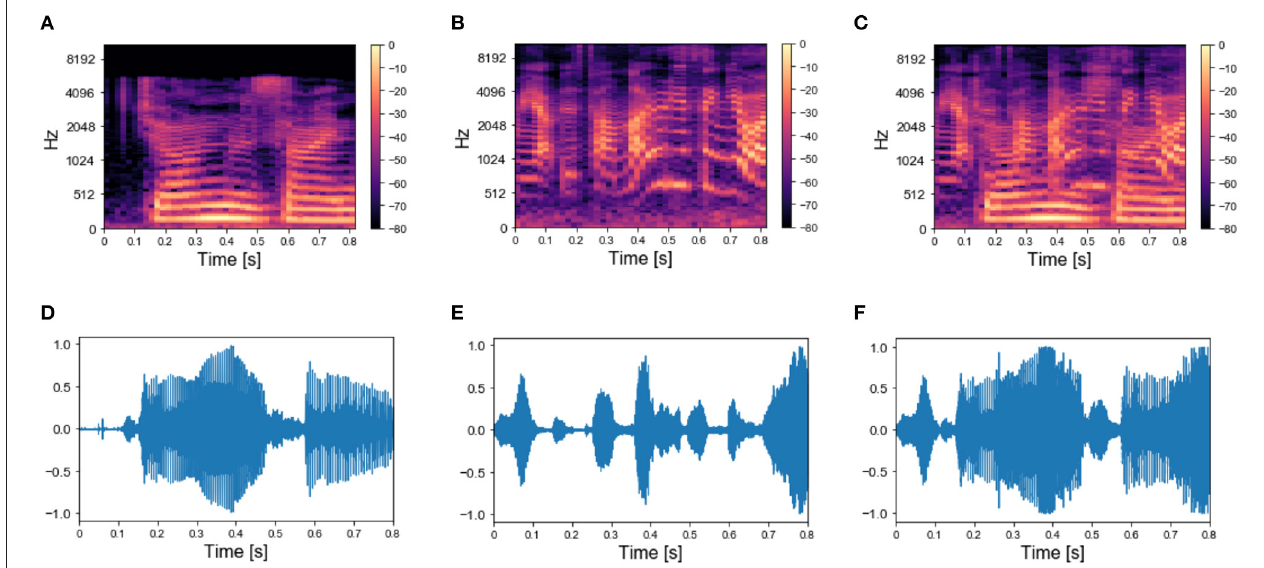
FIGURE 7 | Real-world sounds—targets and mixture. (A) Spectrogram of a spoken sentence 800 ms-long. (B) Spectrogram of 800 ms-long recording of chimes sounds. (C) Spectrogram of the mixture of the sounds in (A,B) . (D) Sound wave associated with the spectrogram in (A) . (E) Sound wave associated with the spectrogram in (B) . (F) Sound wave associated with the spectrogram in (C)